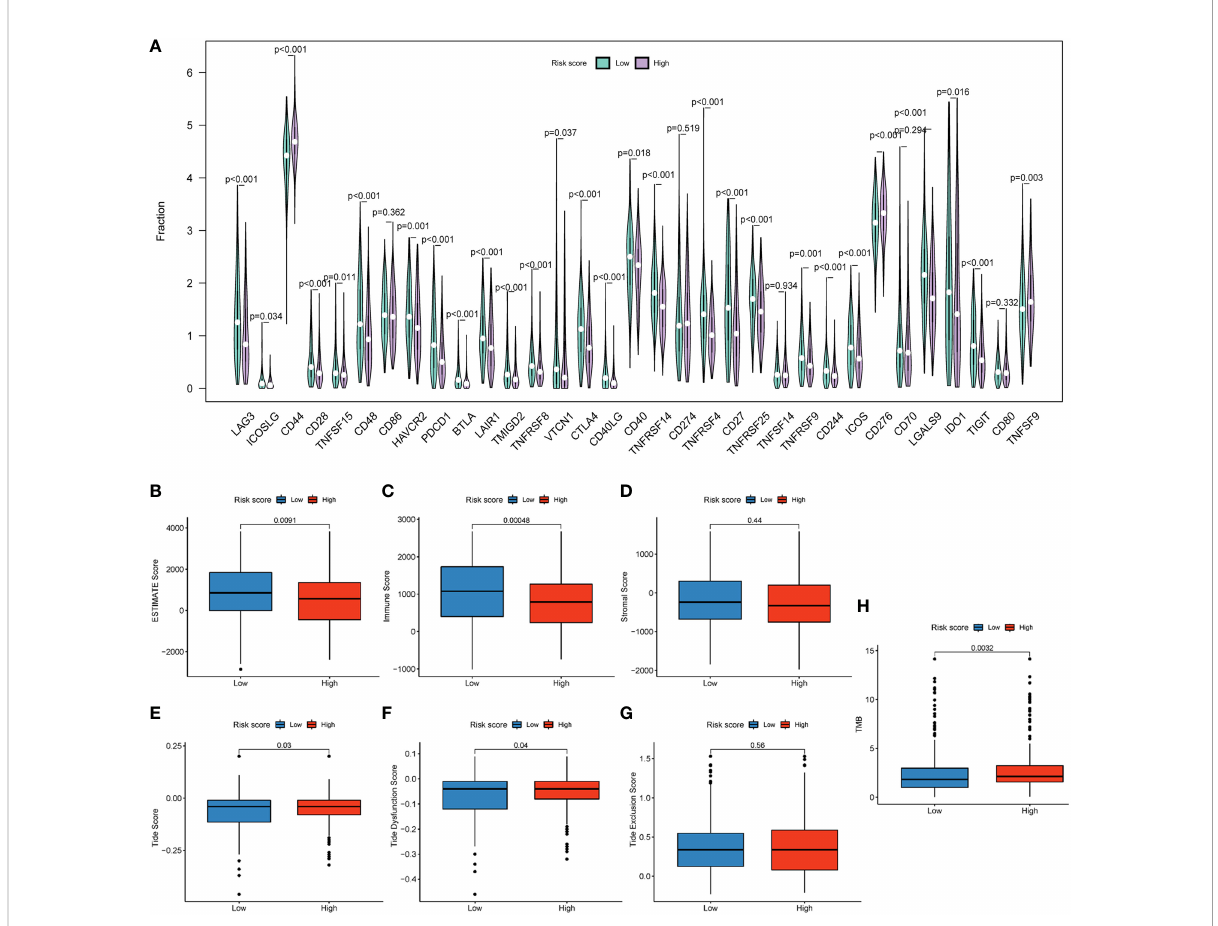
FIGURE 8 An HRG-based prognostic signature for the evaluation of immune checkpoint therapy. (A) The expression of 37 immune checkpoint genes. (B) Boxplot showed differences between different groups in the ESTIMATE score. (C) Boxplot showed differences between different groups in the stromal score. (D) Boxplot showed differences between different groups in the immune score. Boxplot showed differences of different groups in the Tide score (E) , TIDE Dysfunction score (F) , and TIDE Exclusion score (G) . (H) Boxplot showed differences in TMB